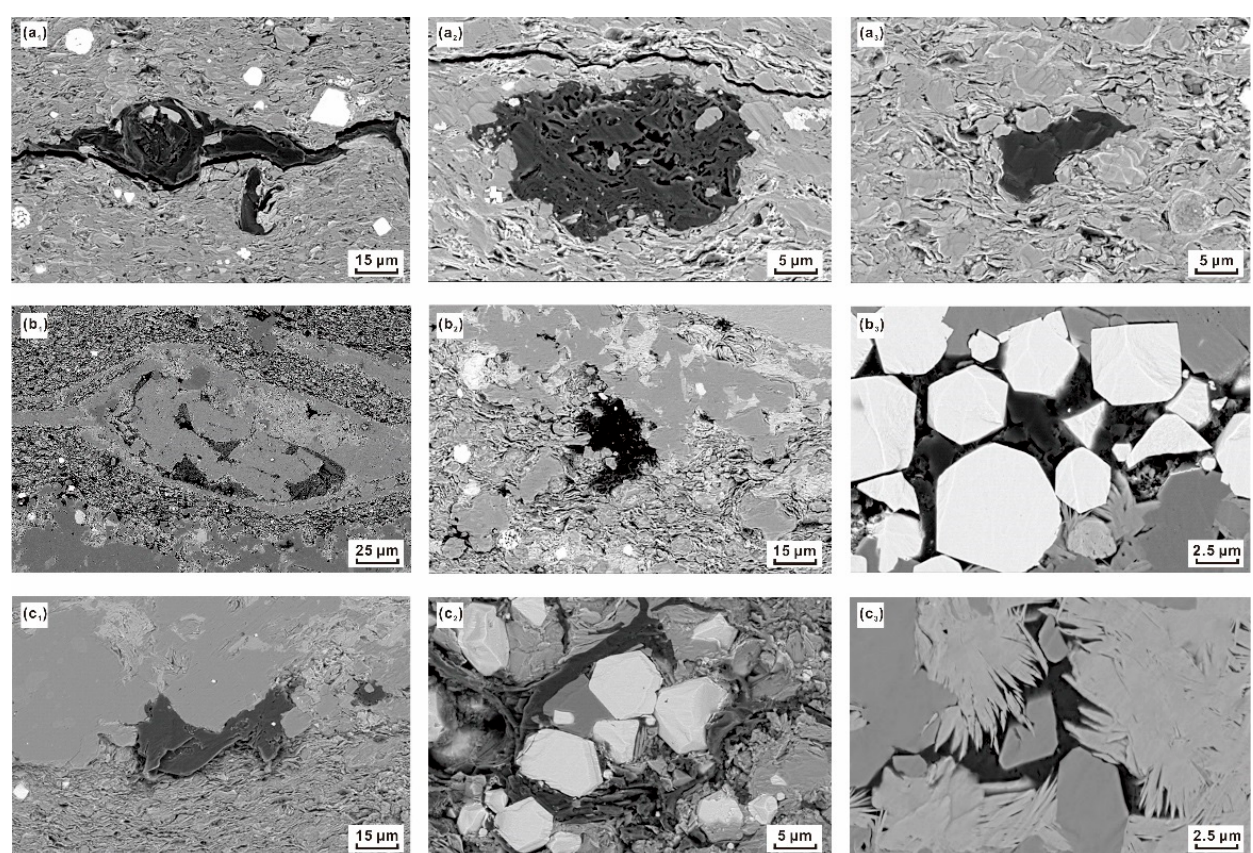
Figure 5. Types and characteristics of organic pores in different laminae. ( a 1 –a 3 ) are UA, ( b 1 –b 3 ) are UB and ( c 1 –c 3 ) are UC. ( a 1 ) Elongate agglomerated organic matter and striated fractures; ( a 2 ) ellip- soidal agglomerated organic matter; ( a 3 ) irregular agglomerated organic matter; ( b 1 ) gap-filling or- ganic matter between Ostracod shells; ( b 2 ) irregular agglomerated organic matter; ( b 3 ) gap-filling organic matter between pyrites; ( c 1 ) irregular organic matter associated with quartz and clay min- erals; ( c 2 ) gap-filling organic matter; ( c 3 ) gap-filling organic matter.